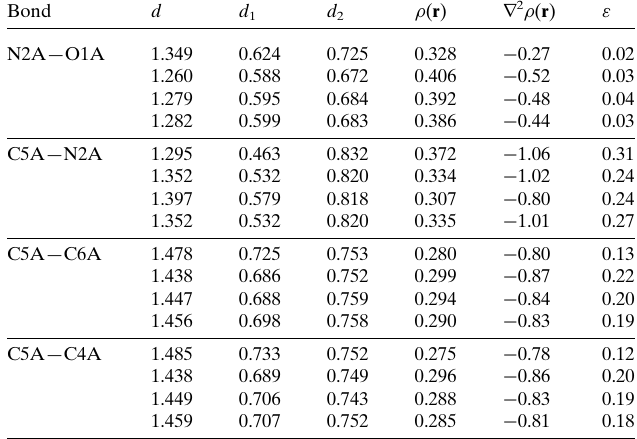
Figure 7 Correlation between directions of optical indicatrix axes (refractive indices) and crystallographic axes in the structure of (I) ( a , b ) and (II) crystals ( c , d ). Table 2 Topological analysis of BCPs for selected bonds in VA (first row), (II) (second row), (III) (third row) and (I) (fourth row). d , intermolecular distance (A˚ ); d 1, d 2, distance between BCPs and interacting atoms (A˚ ); (cid:7) ( r ), charge density (a.u.); r 2 (cid:7) ( r ), Laplacian of electron density (a.u.); " , bond